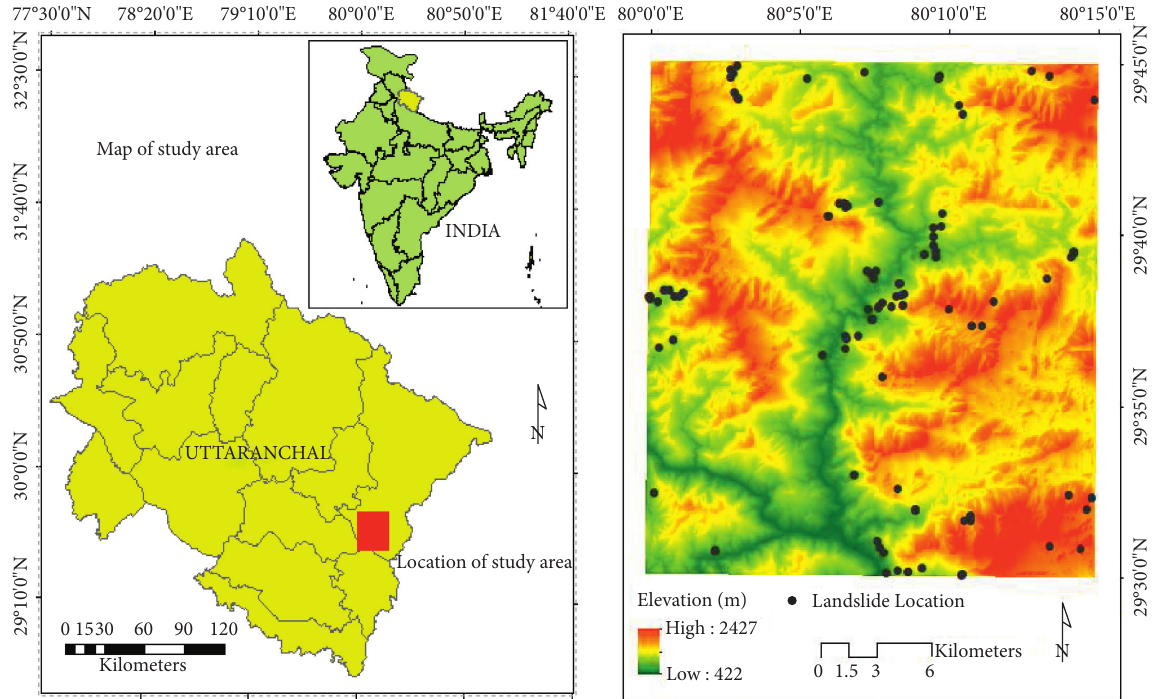
Figure 1: Landslide’s location map of study area.